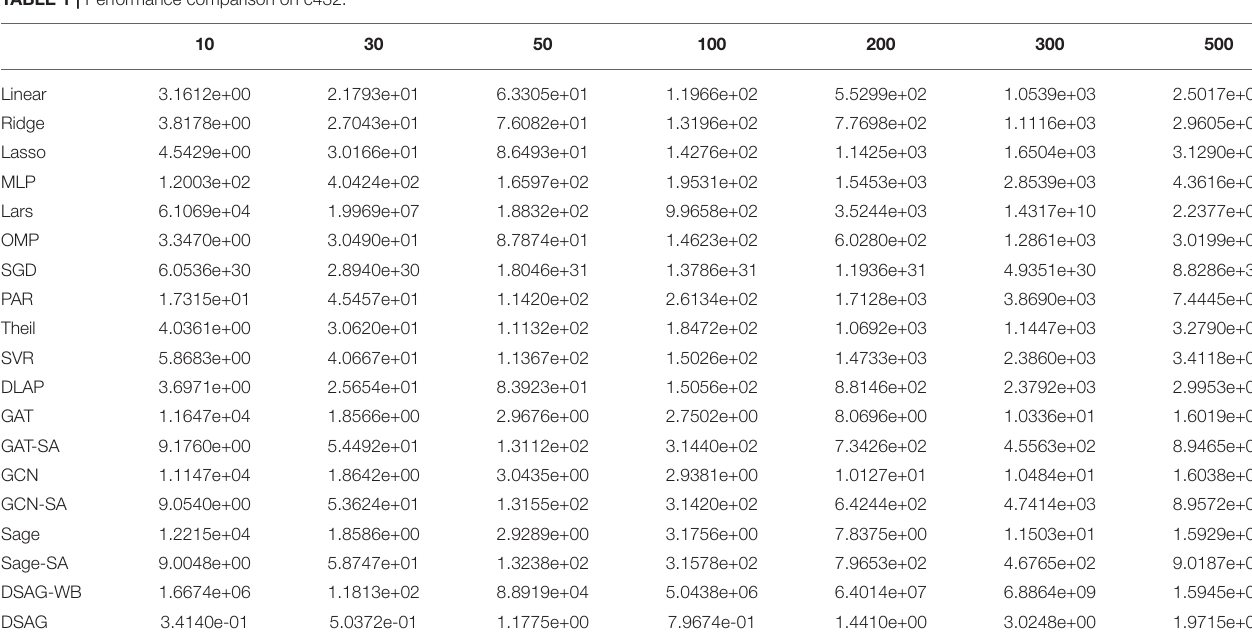
TABLE 1 | Performance comparison on